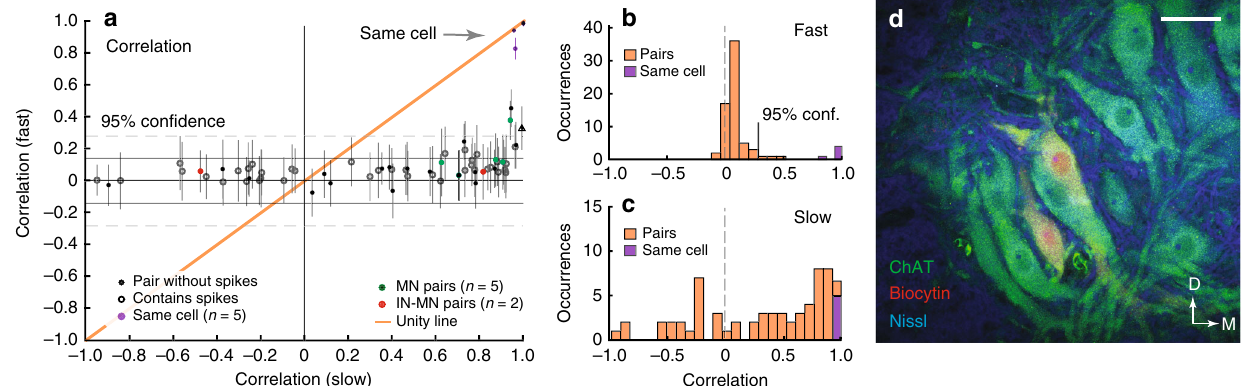
Fig. 5 Decoupling of slow and fast timescales of synaptic input. a Correlation in synaptic input to pairs of neurons ( n = 66) on slow timescale (i.e. input rate modulation, abscissa) vs. fast correlation (synaptic potentials, ordinate). A departure from the unity line (orange) indicates that correlated rate modulation is not caused by the same synaptic drive. As a control, paired recordings from same cells ( n = 5) do not exhibit such a departure (purple points indicated). Con fi dence limits assessed as 2 σ from the mean of shuf fl ed data ( σ = standard deviation). Pair from Fig. 4a – e indicated (triangle). Error bars indicate standard deviation. b Synaptic correlation (fast) is scattered close to zero (with a slight positive bias) and has only 4.5% ( n = 3/66) above the 95% con fi dence limit. c Slow correlation has a weak mode close to 1. d Close proximity of MNs (biocytin (red) and Choline Acetyl Transferase – stained (ChAT, green)) does not grant high correlation in synaptic input ( R = 0.36, right green point in a ). Nissl stain in blue. Location in the left ventral horn. Scale bar 50 μ m . D: Dorsal, M: Medial. Each point in a represents the mean correlation of repeated measures of same sample pair with standard deviation as error not due to electrotonic fi ltering. These data also ensure that the not exhibit a parallel correlation in the fast activity. This was recorded fl uctuations, which may appear to be noise, are shown as a departure from the unity line, i.e., a decoupling of correlated in both electrodes, and it is therefore not electronic timescales (Fig. 5a). A majority of the pairs had a near zero noise, but rather fl uctuations in synaptic input. correlation on a fast timescale (Fig. 5b). Only three out of 66 pairs Separation of fast and slow synaptic timescales was performed (4.5%) had a correlation higher than 2 σ from the mean of the for all pairs, both IN-MN and MN – MN pairs ( n = 66 in total), distribution for shuf fl ed pairs, which is within what is expected by and plotted against each other (Fig. 5a). Pairs that belong to the chance for the 95% con fi dence limit (solid vertical line). When same functional module, i.e., have a strong slow correlation, did choosing slow correlation >0.8 there was n = 3/17 points (17.6%)